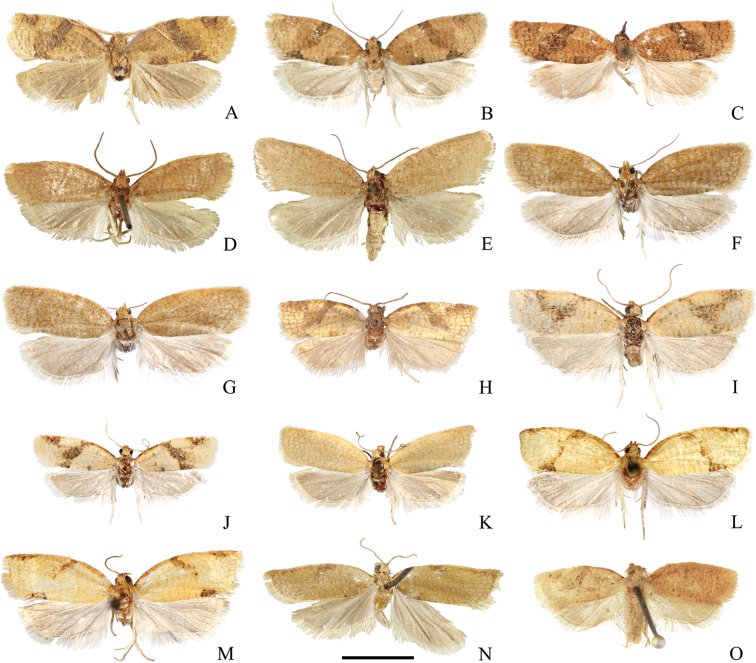
Adults of Clepsis
neglectana species group A–CC.
neglectana: A lectotype of Tortrix
neglectanaB male, Southern Germany C Female, Germany D–GC.
striolana: D lectotype of T.
striolanaE paralectotype of T.
striolanaF male, Austria, South Tyrol G female, Austria, South Tyrol H–KC.
trivia: H holotype of T.
triviaI–J males, Crete K female, Crete L–MC.
acclivana: L lectotype of Cacoecia
acclivanaM paralectotype of C.
acclivanaNT.
severana holotype OCacoecia
unifasciana
var.
semiana holotype. Scale bar: 5 mm, all to scale.